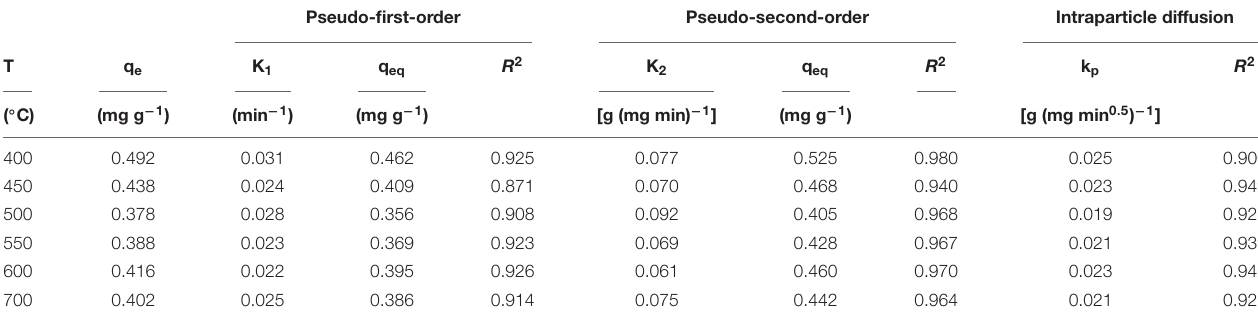
TABLE 3 | The adsorption kinetic parameters of BCCP under different calcined temperatures.